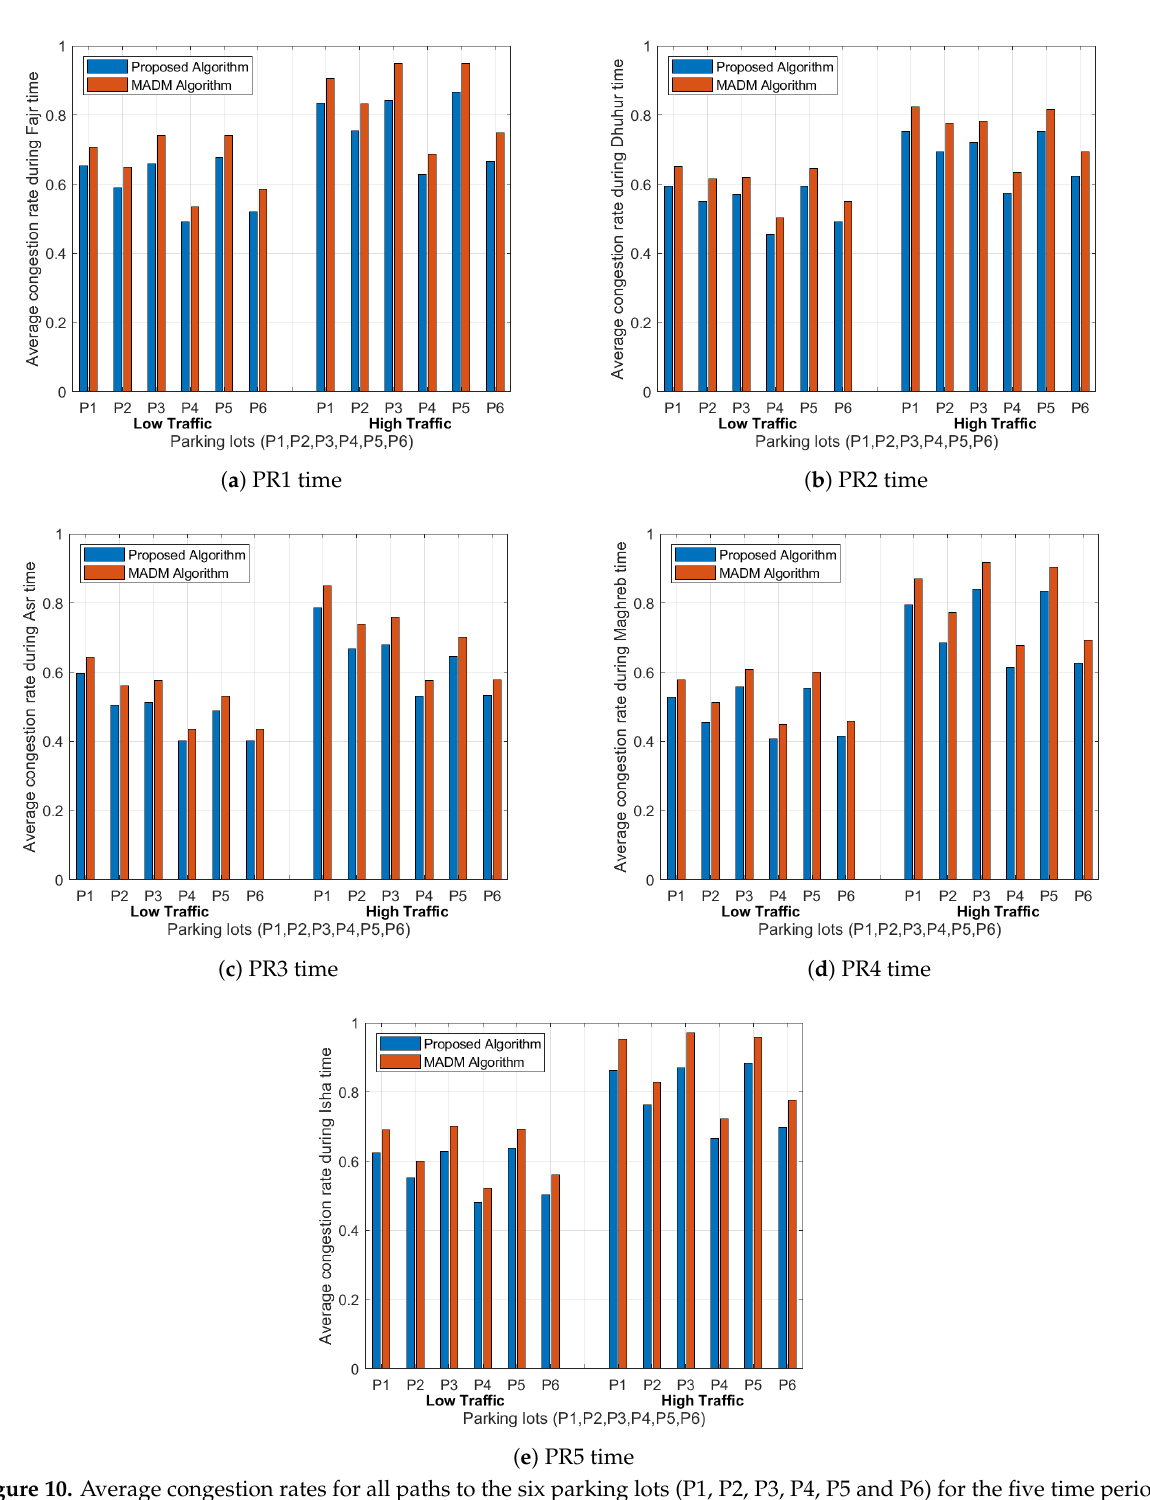
Figure 10. Average congestion rates for all paths to the six parking lots (P1, P2, P3, P4, P5 and P6) for the five time periods (PR1–PR5) for both algorithms under low and high traffic